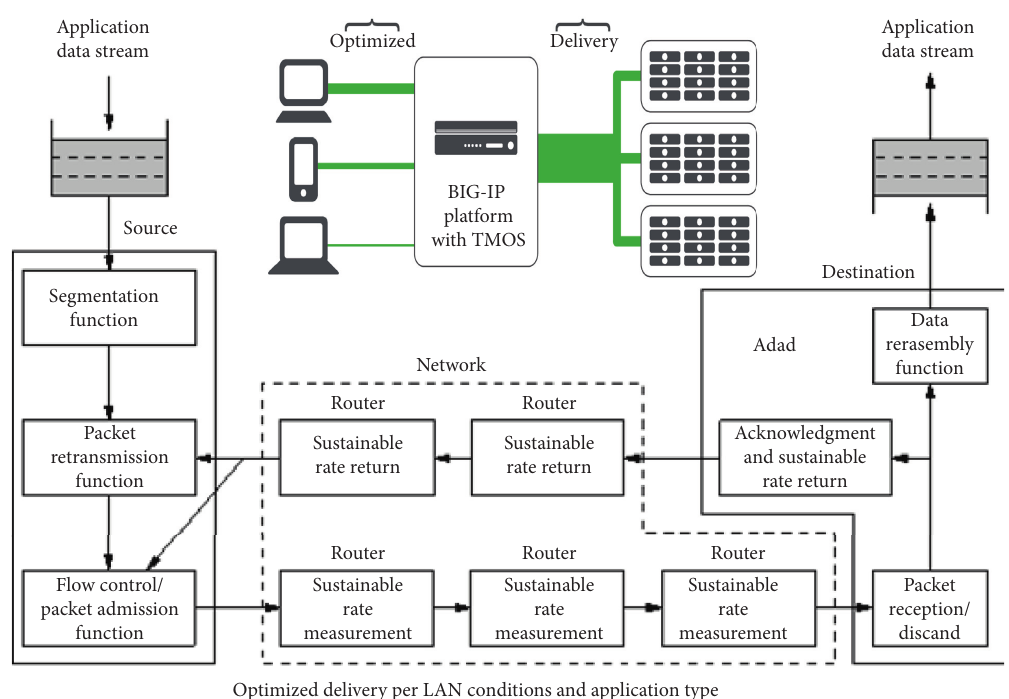
Figure 1: Framework of the nonvisual congestion control